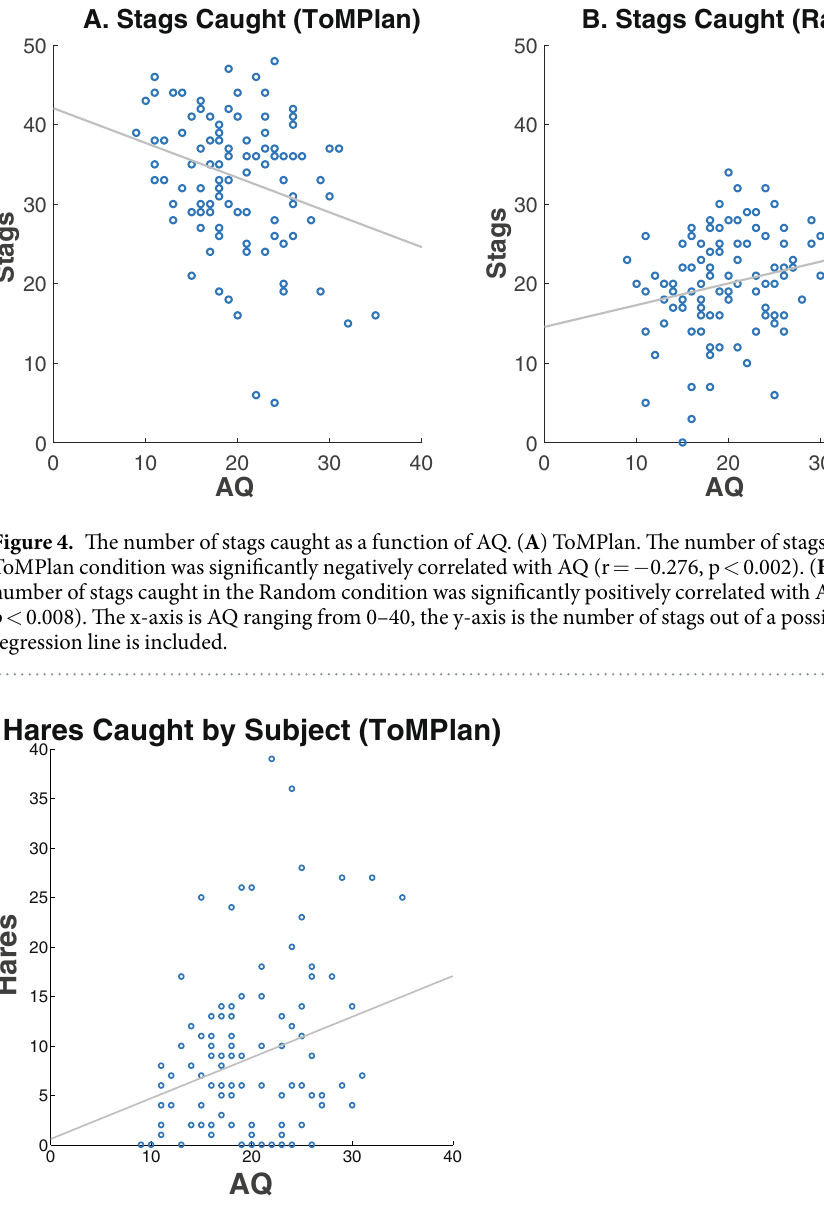
Figure 5. Average number of hares caught by subjects as a function of AQ during the ToMPlan condition. A significant positive correlation was found in the ToMPlan condition (r = 0.264, p < 0.003), indicating that subjects with higher AQ tended to catch more hares than in lower AQ subjects. The x-axis is AQ ranging from 0–40, the y-axis is the number of hares out of a possible 50, and the regression line is